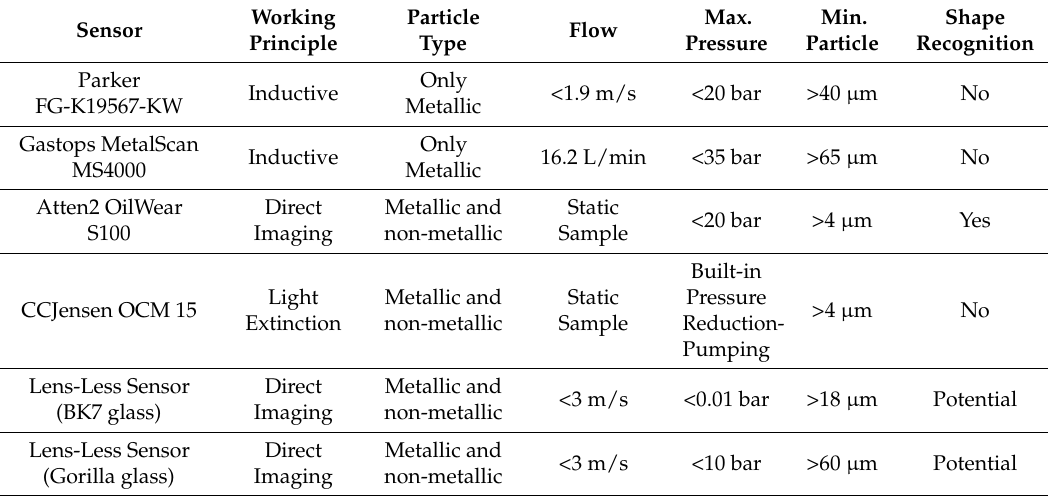
Table 4. Particle detection and classification execution time using the different CPUs